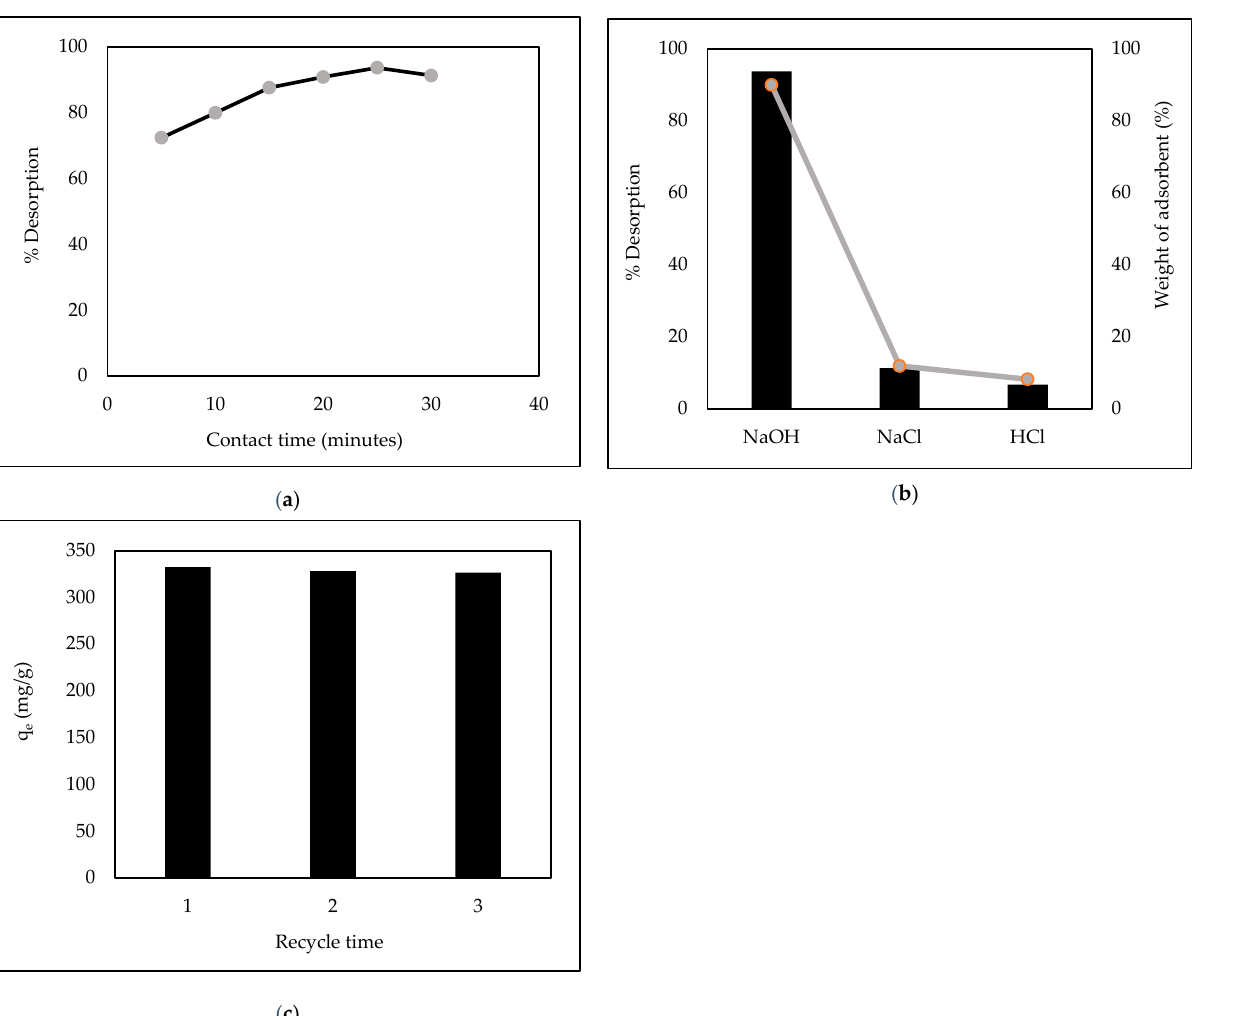
Figure 12. Desorption studies. ( a ) Release of AR88 in contact time by NaOH; ( b ) release of AR88 with different desorbing agents; ( c ) regeneration of AR88.